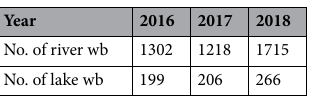
Table 1. Number of water bodies monitored in the period